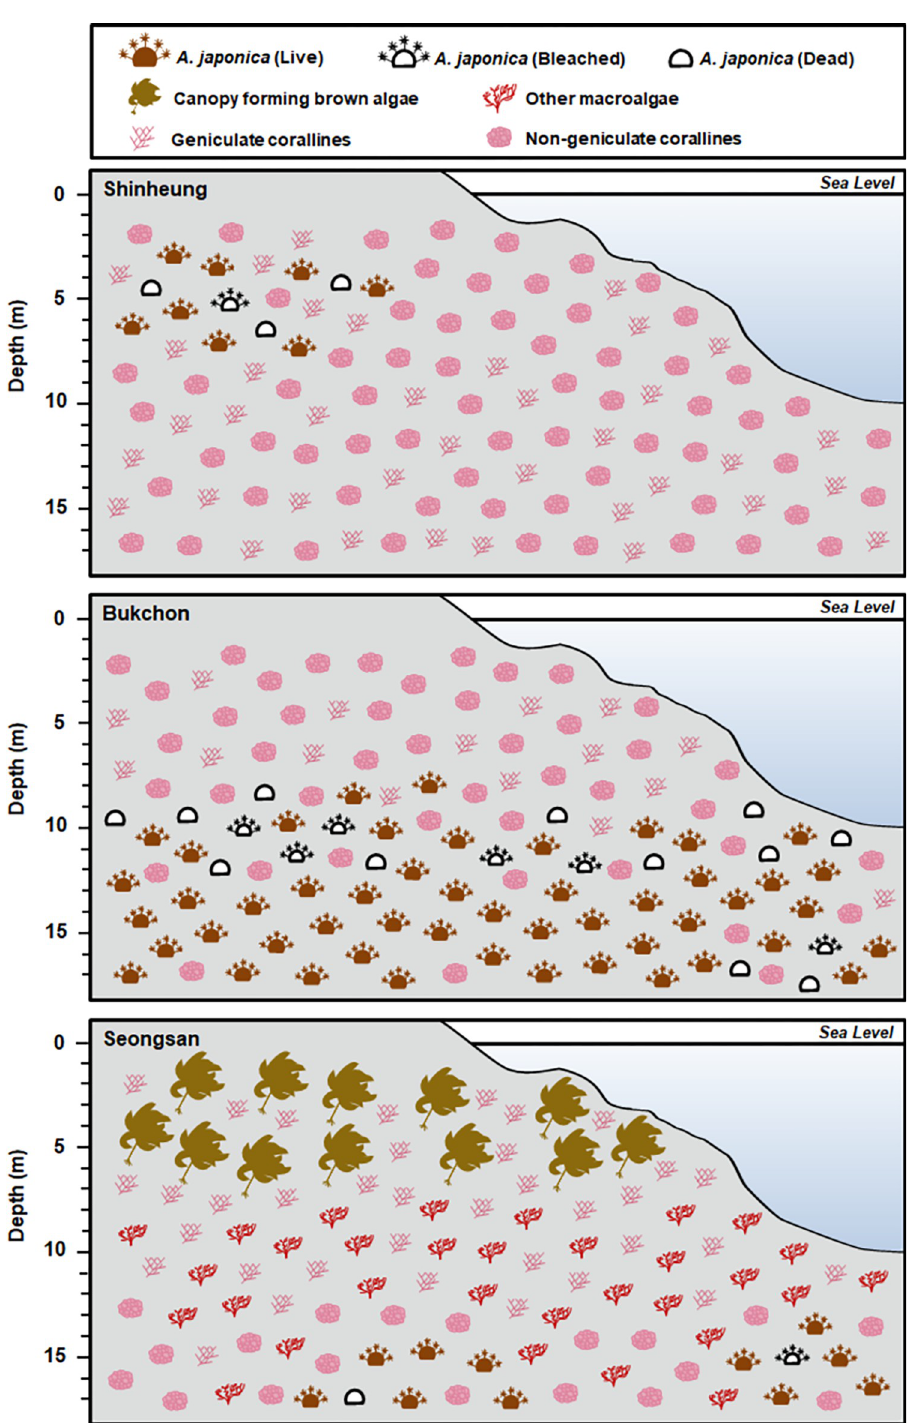
Fig 4. Illustration of major benthic community and different conditions: Live, bleached, and dead colonies of A . japonica occurring at different depths in 3 survey sites SH, BC, SS in Jeju Island, Korea.